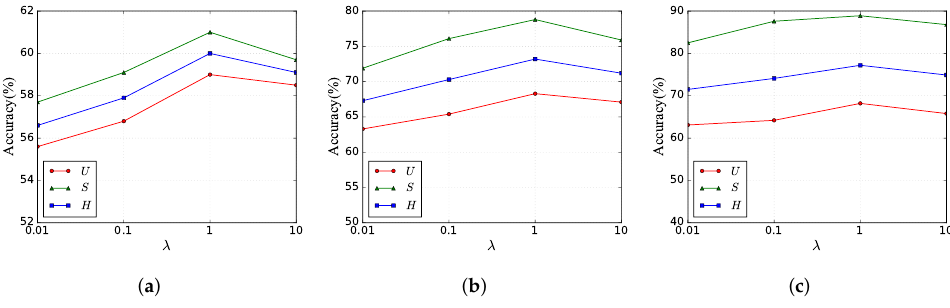
Figure 4. The effect of hyper-parameter λ : ( a ) CUB; ( b ) AWA2; and ( c ) FLO.